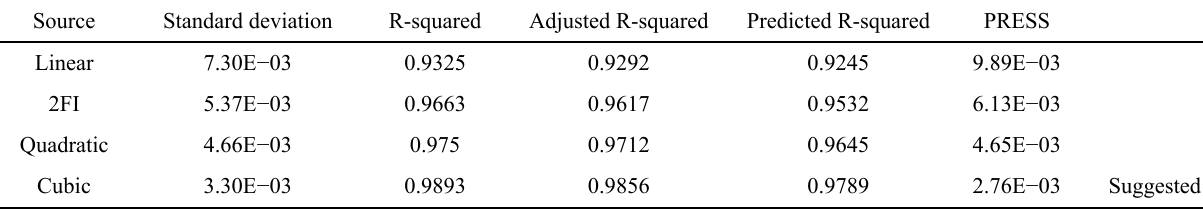
Table 11 R-Squared values for different models in case of maximum contact temperature.